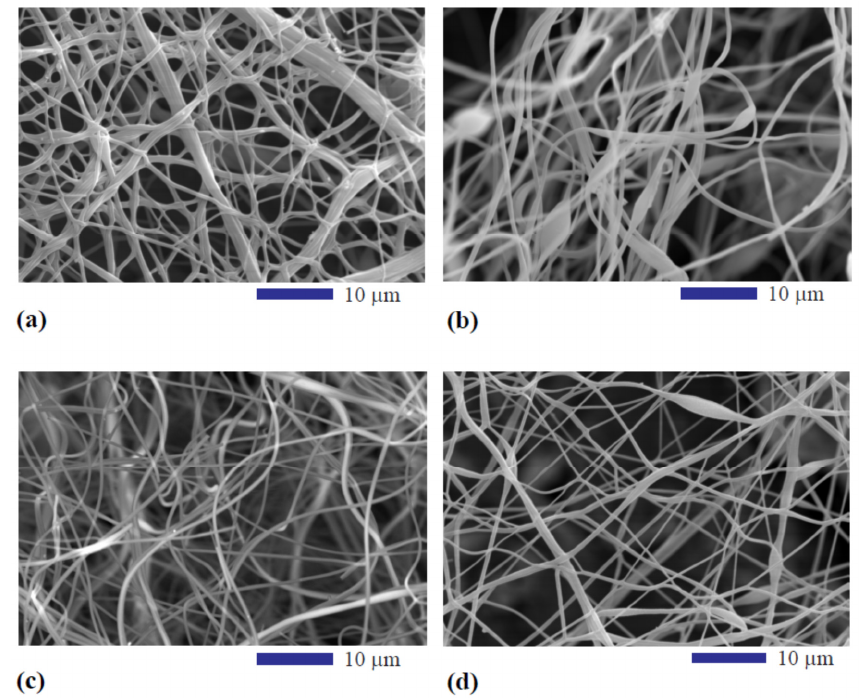
Figure 2. SEM images showing: ( a ) the oxidized fiber heat treated at 250 ◦ C; ( b ) the carbonized fiber heat treated at 450 ◦ C; ( c ) the carbonized fiber heat treated at 600 ◦ C; ( d ) the carbonized fiber heat treated at 650 ◦